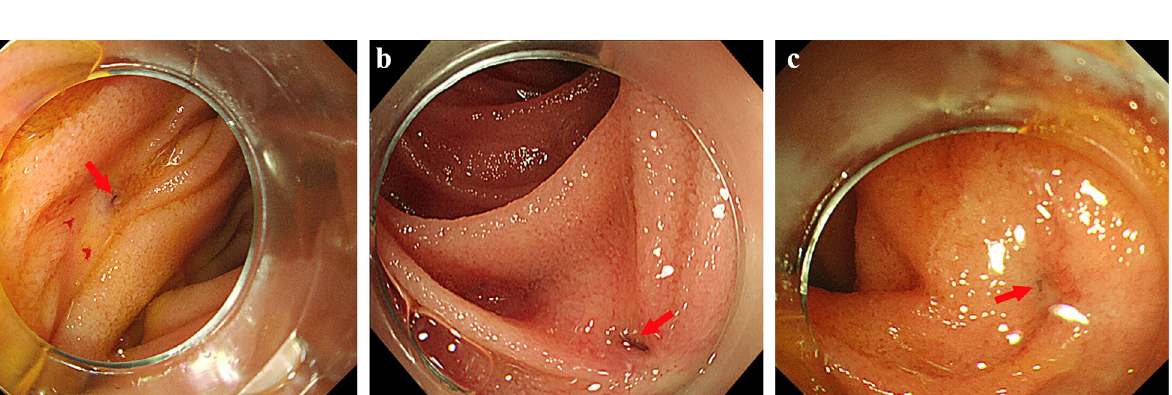
Figure 1. Endoscopic findings at the anastomotic site. ( a ) The anastomotic site with pinhole-like opening was located frontward to the endoscopic view. The red arrow shows the anastomotic site. ( b ) The anastomotic site with slit-like opening was located tangent to the endoscopic view. The red arrow shows the anastomotic site. ( c ) The anastomotic site with scarred, membranous stenosis was located tangent to the endoscopic view. The red arrow shows the anastomotic